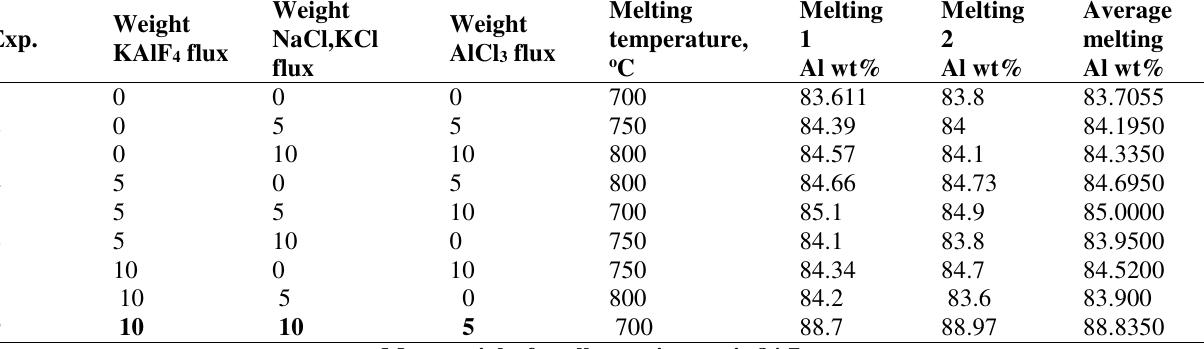
Values and average of melting percentage of Aluminum with and without using flux at different temperature at (TOA) L 9 .